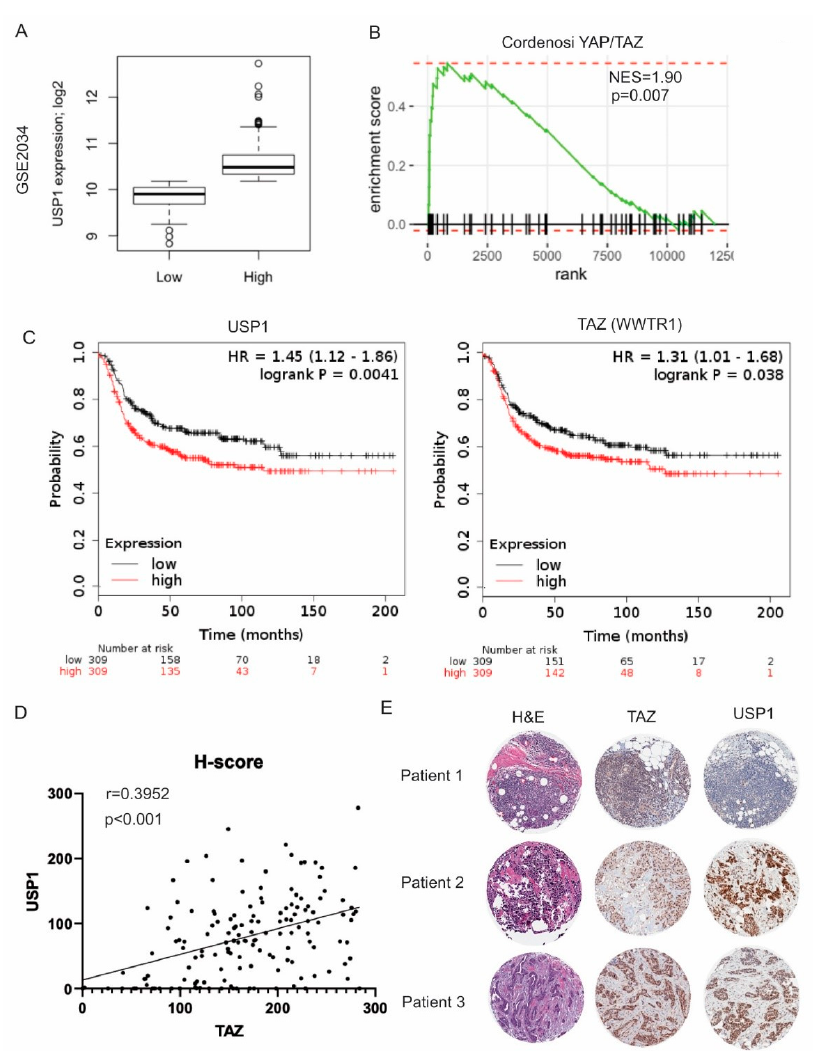
Figure 6. USP1 and TAZ expression are correlated in TNBC. ( A ) Stratification of GSE2034 into USP1 low- and USP1 high- subsets. ( B ) Cordenosi YAP / TAZ gene signature is highly correlated with USP1 high-subset patients. ( C ) Kaplan-Meier relapse free survival analysis curves for USP1 and TAZ in breast cancer patients. ( D ) The dot plot represents the correlation of USP1 and TAZ in all the TMAs stained indicating a positive correlation between staining intensity of ALL samples. Pearson correlation between USP1 and TAZ protein levels were quantified by Aperio Image Scope of TNBC patients treated at RPCCC. Data are shown as the mean ± SD. Unpaired two-tailed student t-test: * p < 0.05, ** p < 0.01, *** p < 0.001. ( E ) Representative images of H&E and IHC staining of tumor microarrays (TMAs) from TNBC patients treated at Roswell Park Comprehensive Cancer